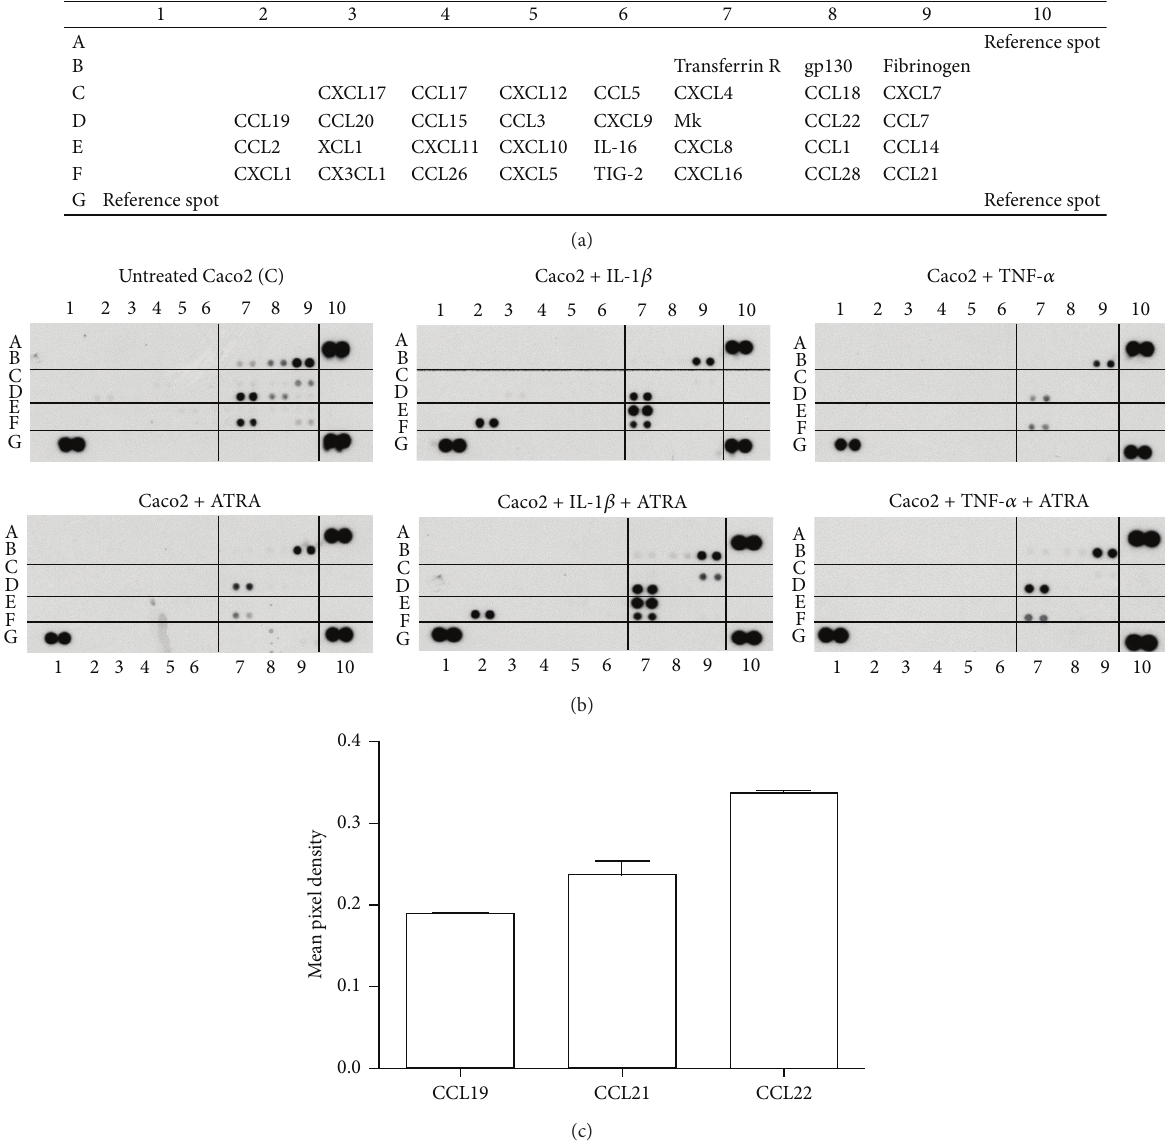
Figure 1: Chemokine secretion of human epithelial cells activated by IL-1 𝛽 or TNF- 𝛼 in the presence or absence of ATRA. Caco2 cells were activated by 10ng/mL IL-1 𝛽 or TNF- 𝛼 in the presence or absence of 10nmol ATRA. After 1hr of activation, the supernatants were removed andthecellswerewashedandculturedinfreshmedium.After5 hrthesupernatantsofnontreatedandactivatedCaco2cellswerecollectedand the relative levels of chemokines were determined by a Proteome Profiler Array used according to the manufacturer’s instructions. The relative levels of the Caco2 cell-derived chemokines were determined by calculating mean pixel densities of the individual blots normalized to sample control fibrinogen. The mean ± SD of 4 independent measurements is shown. (a) Localization of the chemokine probes in the membranes related to the positive controls and the reference spots. (b) Representative dot blots showing the relative expression of chemokines produced by untreated Caco2 cells without or with ATRA (upper and lower panels 1) as compared to Caco2 cells stimulated by IL-1 𝛽 (upper panel 2) and IL-1 𝛽 in the presence of ATRA (lower panel 2). Upper and lower panels 3 correspond to Caco2 cells stimulated by TNF- 𝛼 in the absence or presence of ATRA, respectively. (c) Relative expression levels of CCL chemokines produced by unstimulated Caco2